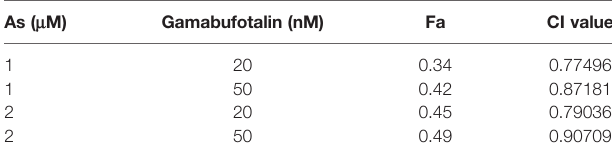
TABLE 2 | CI values of the combination of relatively low concentrations of As III and gamabufotalin in U-87 cells. As ( m